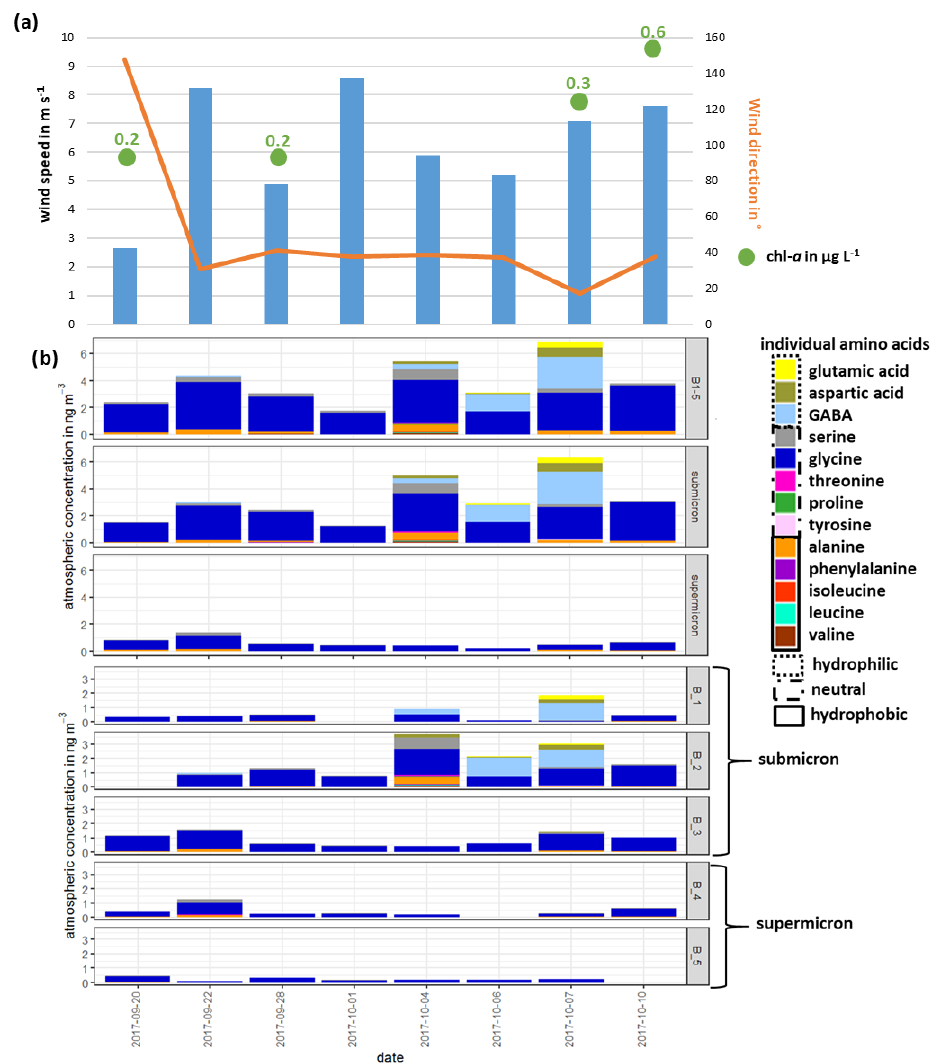
Figure 2. (a) Overview of wind speed and wind direction at the CVAO and the chl a concentration in seawater; (b) atmospheric concentration of individual FAAs: sum of all Berner stages (B1–5) in the submicron and supermicron size ranges (upper panel) and the atmospheric concentration of FAA in all individual Berner stages (lower panel) during the campaign at the CVAO